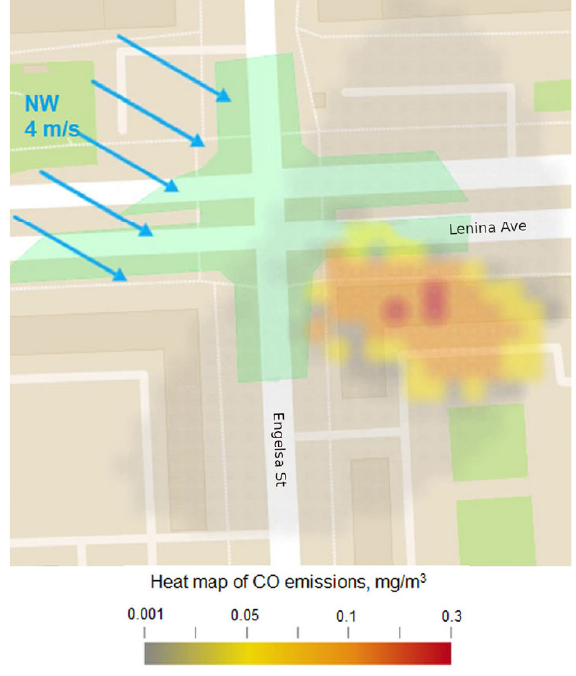
Figure 6. Calculated CO concentration in each area of the grid.